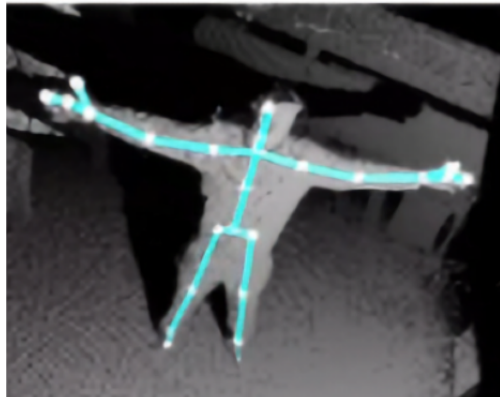
Figure 6. Example skeleton representation obtained from Microsoft Kinect v2 (overlaid on the depth image). The skeleton consists of 25 joints (shown as white circles), here connected with light blue lines for better